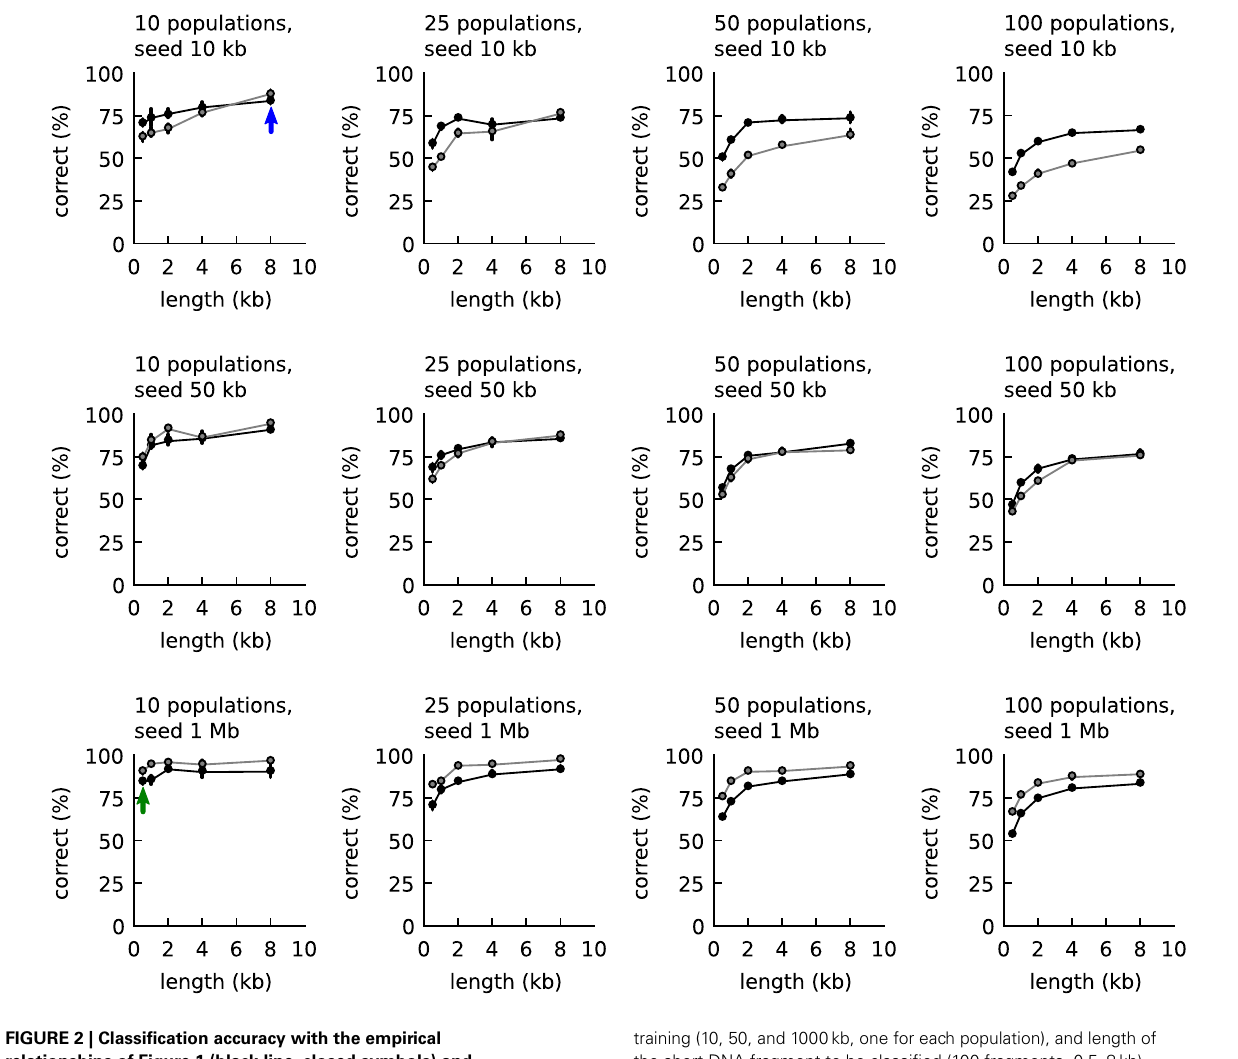
training (10, 50, and 1000kb, one for each population), and length of the short DNA fragment to be classified (100 fragments, 0.5–8kb). Each point is the average of three communities randomly sampled from 794 reference genomes. For the explanation of the blue and green arrow, see main